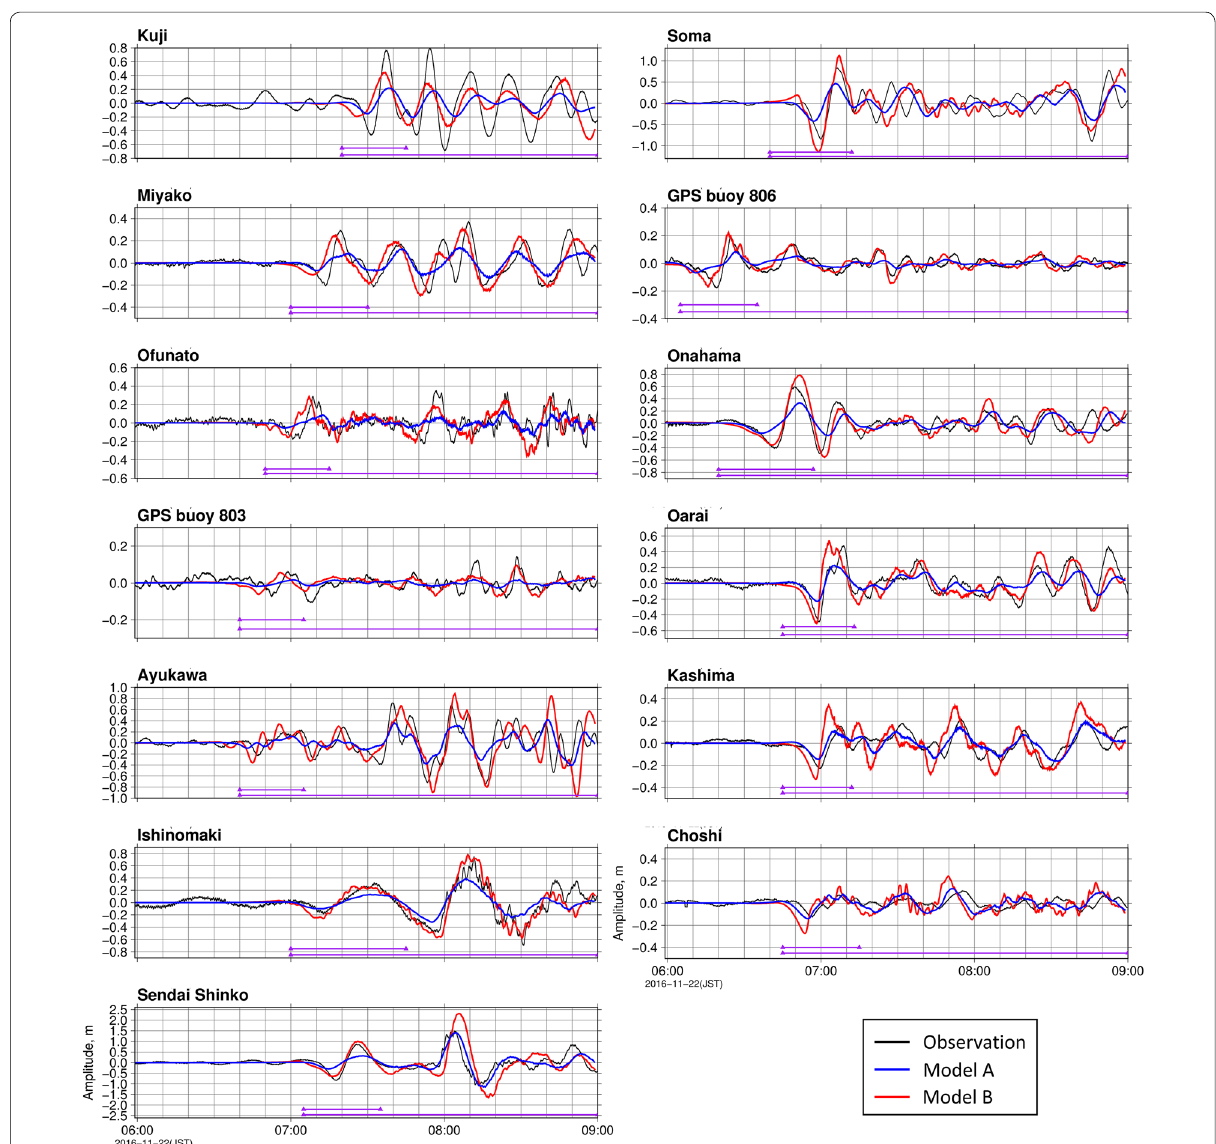
Fig. 4 Comparison of waveforms at 13 stations from observations, model A, and model B. Tsunami waveforms at tide gauge stations and GPS buoys (locations in Fig. 1). Black curves are the observed waveforms, blue curves are waveforms from model A, and red curves are waveforms from model B. Data lengths for calculating VR1 and VR2 at each station are indicated by purple